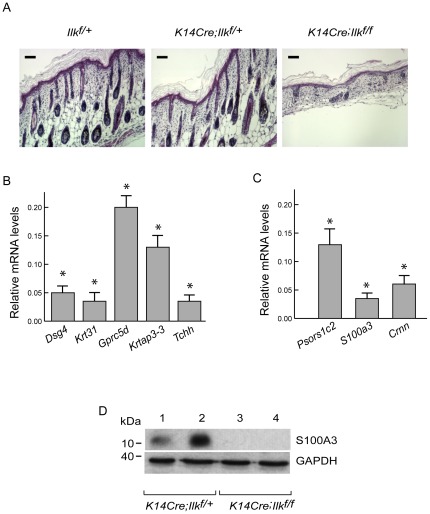
Analysis of hair follicle- and keratinocyte differentiation-associated transcripts in ILK-deficient epidermis.(A) Paraffin sections of skin isolated from 3 day-old mice of the indicated genotype were processed for histological analysis, and stained with hematoxylin and eosin. Bar, 40 µm (B, C) Expression levels of selected transcripts encoding proteins present in the hair follicle (panel B) or in differentiated keratinocytes (panel C) in ILK-deficient K14Cre-Ilkf/f epidermis, determined by qPCR. The results are expressed as the mean+SEM (n = 5), and asterisks indicate P<0.001 (Student's t test) relative to the corresponding transcript levels in ILK-expressing K14Cre-Ilkf/+ epidermis (set to 1). (D) Protein lysates prepared from the skin of 3 day-old mice of the indicated genotypes were resolved by denaturing gel electrophoresis, followed by immunoblot analysis using antibodies against anti-S100A3. The blots were also probed with antibodies against GAPDH, used as loading control.